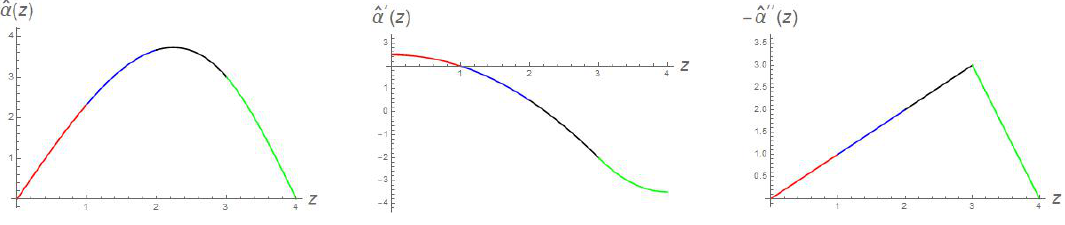
and its derivatives, that describe the CFT associated with 81 (cid:25) 2 N